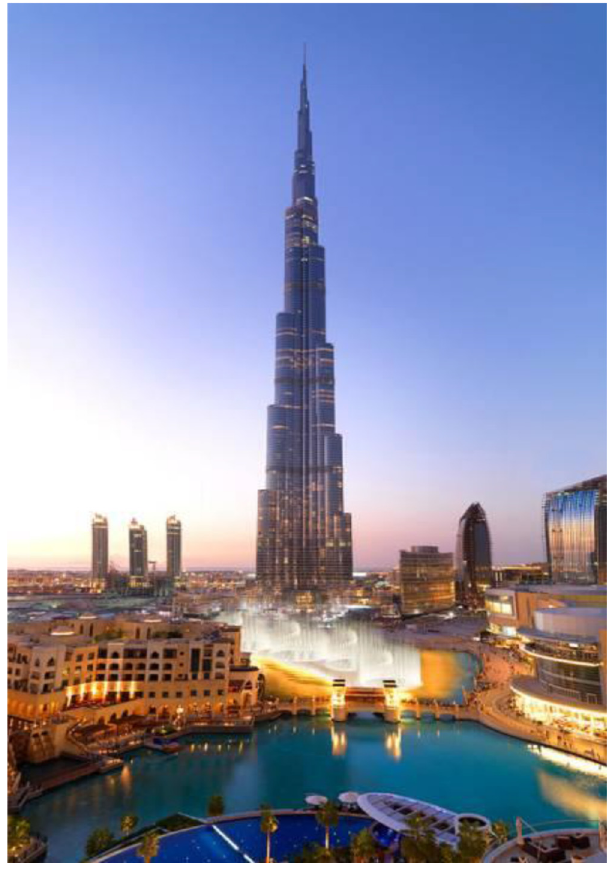
Fig. 1. Development of buildings in